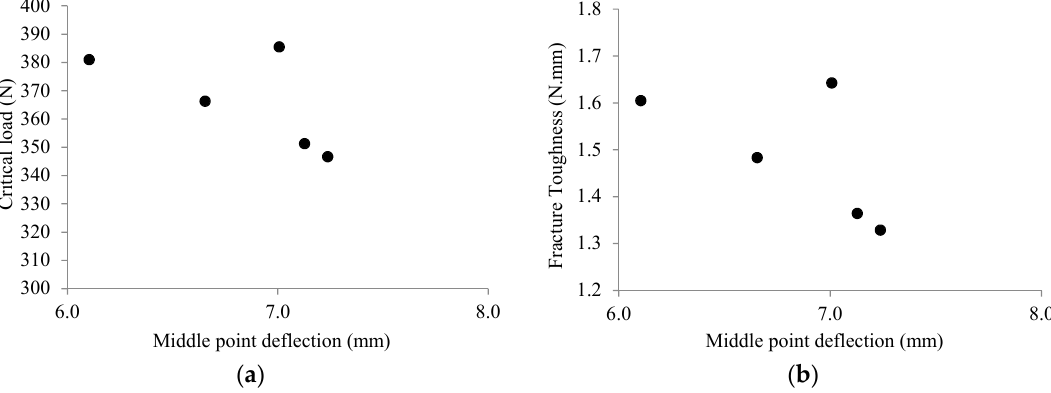
Figure 2. ENF results with a constant crack length (43 mm). ( a ) Variation of critical load versus middle point deflection and ( b ) variation of fracture toughness versus middle point deflection.